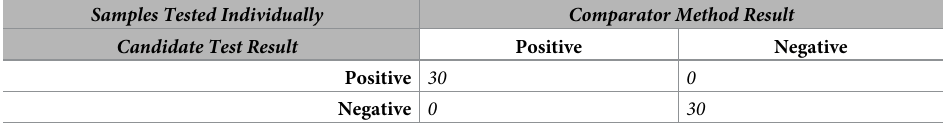
Table 2. Validation of UC Santa Cruz Multiplex SARS-CoV-2 assay by a commercial lab using true positive and true negative clinical samples.